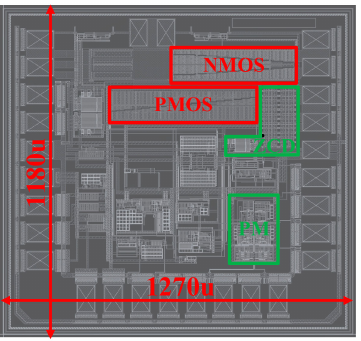
Figure 10. Layout view of the proposed MPPT circuit. A voltage source E TEG and a resistance R TEG were connected in series to mimic the TEG. Figure 11 displays the simulation waveform of the TEG output voltage V TEG when E TEG changed from 50 mV to 400 mV and R TEG was 6 Ω . There is an enlarged view of the simulation results at the bottom of the figure. As described in Section 2, V TEG oscillated between the three states closest to E TEG /2, which is the maximum power point.